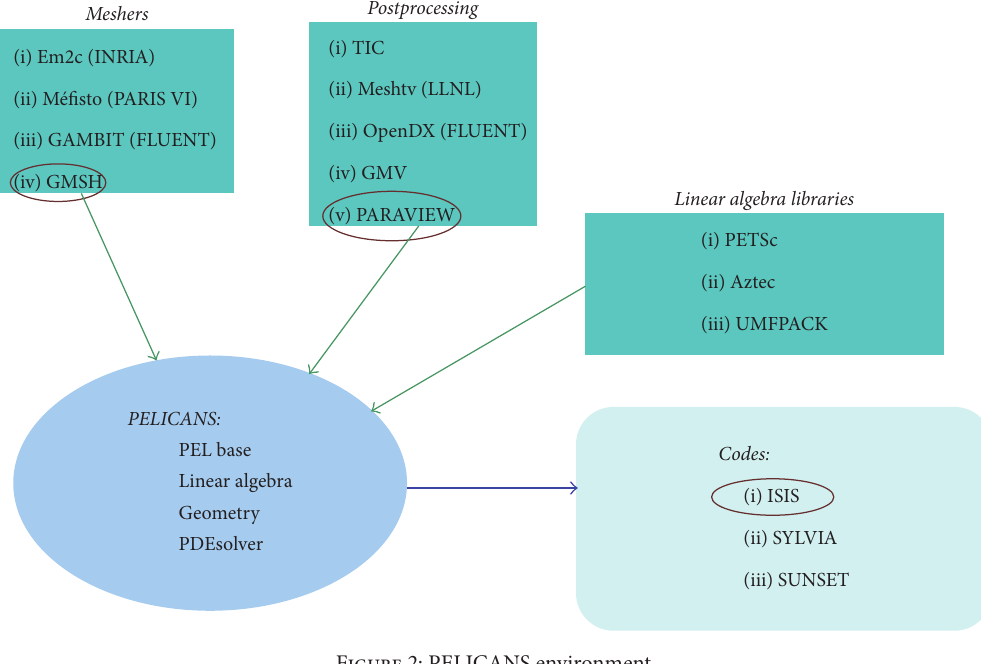
Figure 2: PELICANS